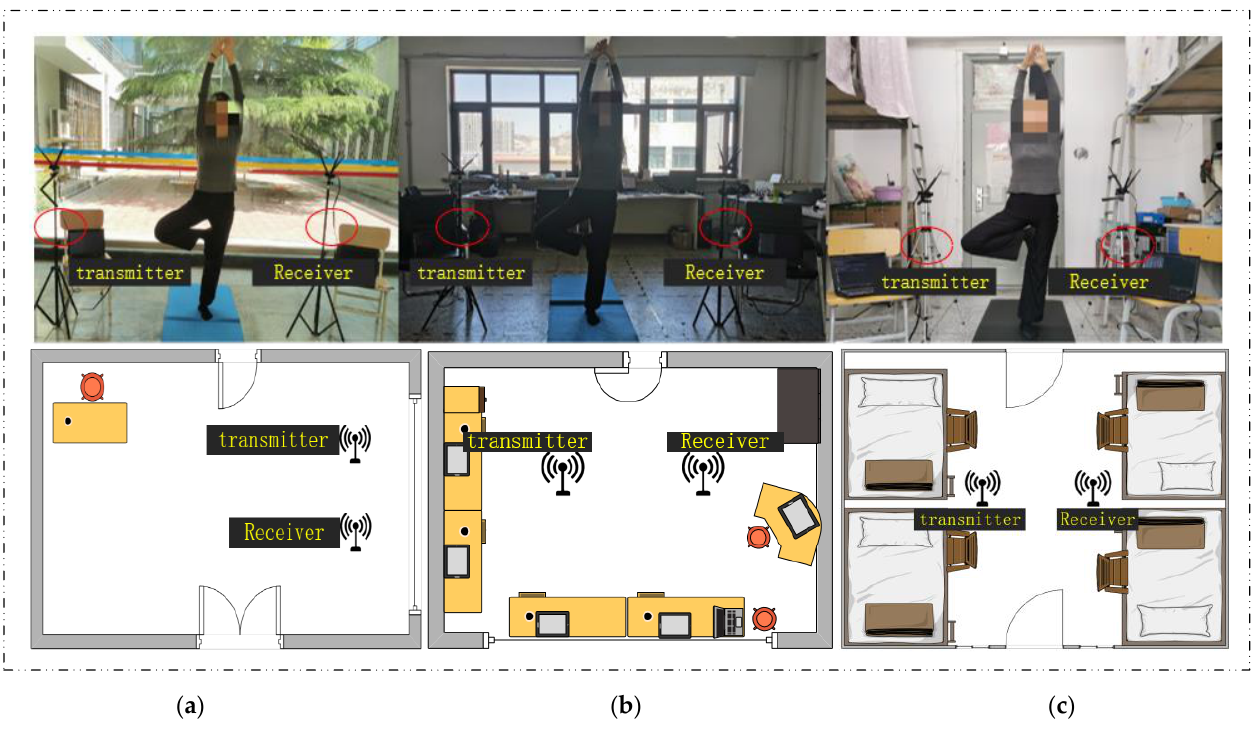
Figure 8. Experimental environment. ( a ) Yoga room; ( b ) laboratory; ( c ) dormitory.